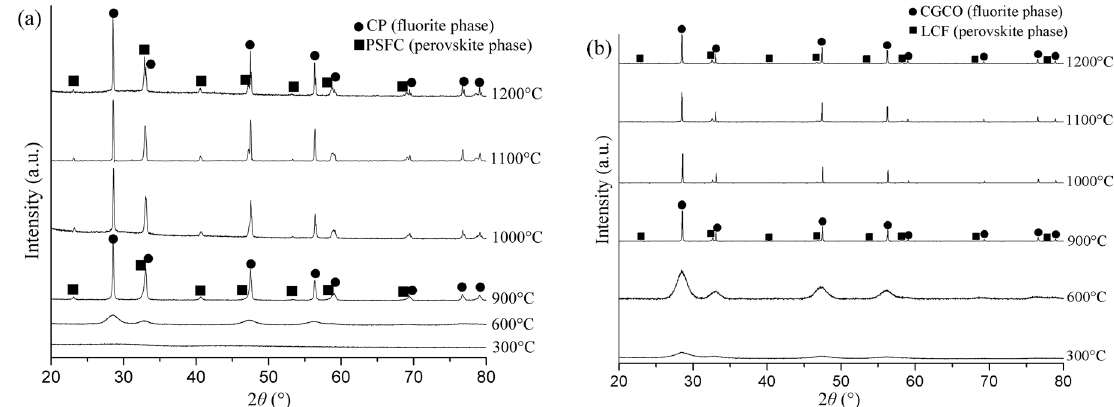
Fig. 3 XRD patterns of (a) 50CP–50PSFC and (b) 75CGCO–25LCF calcined powders respectively at different temperatures.